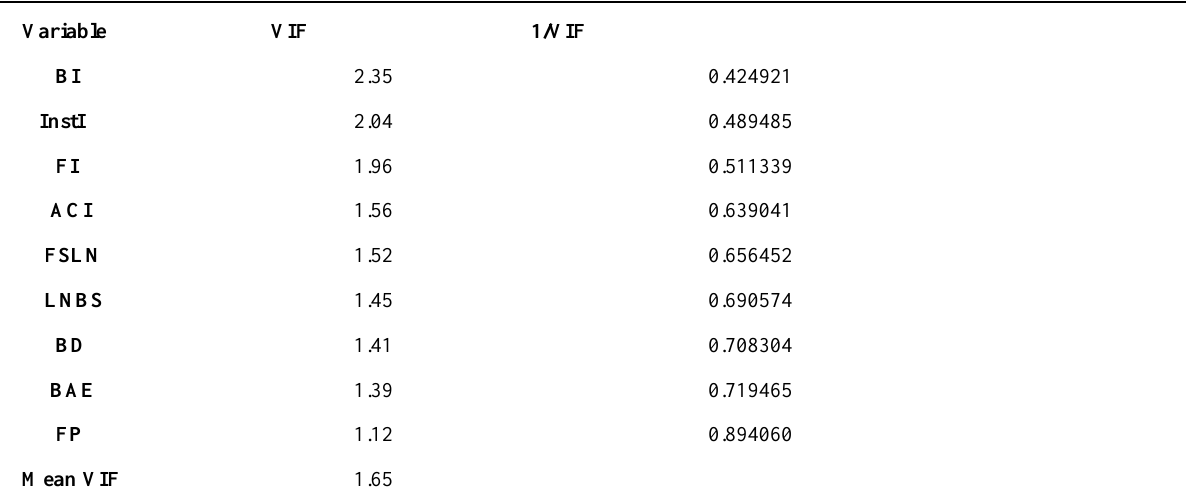
Table 4: Variable Inflation